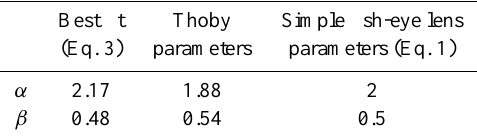
Table 1. A table comparing the best fit and expected results. The expected values come from Thoby (2006), where an experiment was performed on the same Sigma 8mm fisheye lens as SCANDI. This can be further compared with the coefficients in Eq. (1), shown in the last column of the